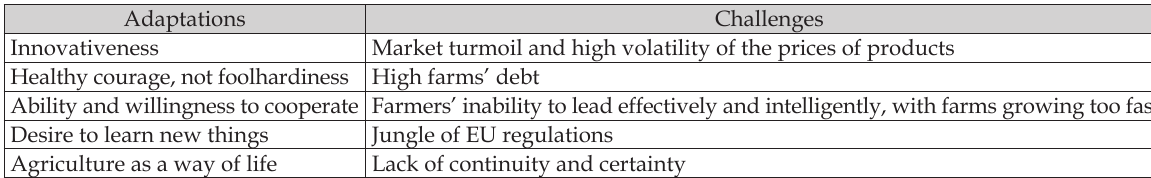
Table 1. Farmers’ key challenges and